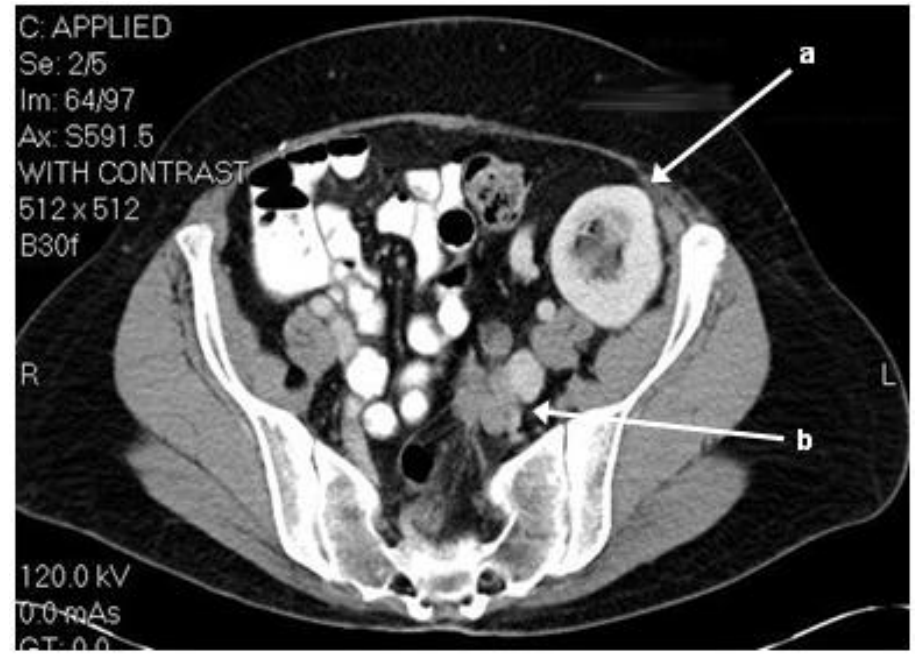
FIGURE 2 . CT of abdomen and pelvis also showed a normal-appearing left transplant kidney (a) and a filling defect in the native left mid-ureter over the sacroiliac joint, with an associated large 5-cm periureteral soft tissue mass